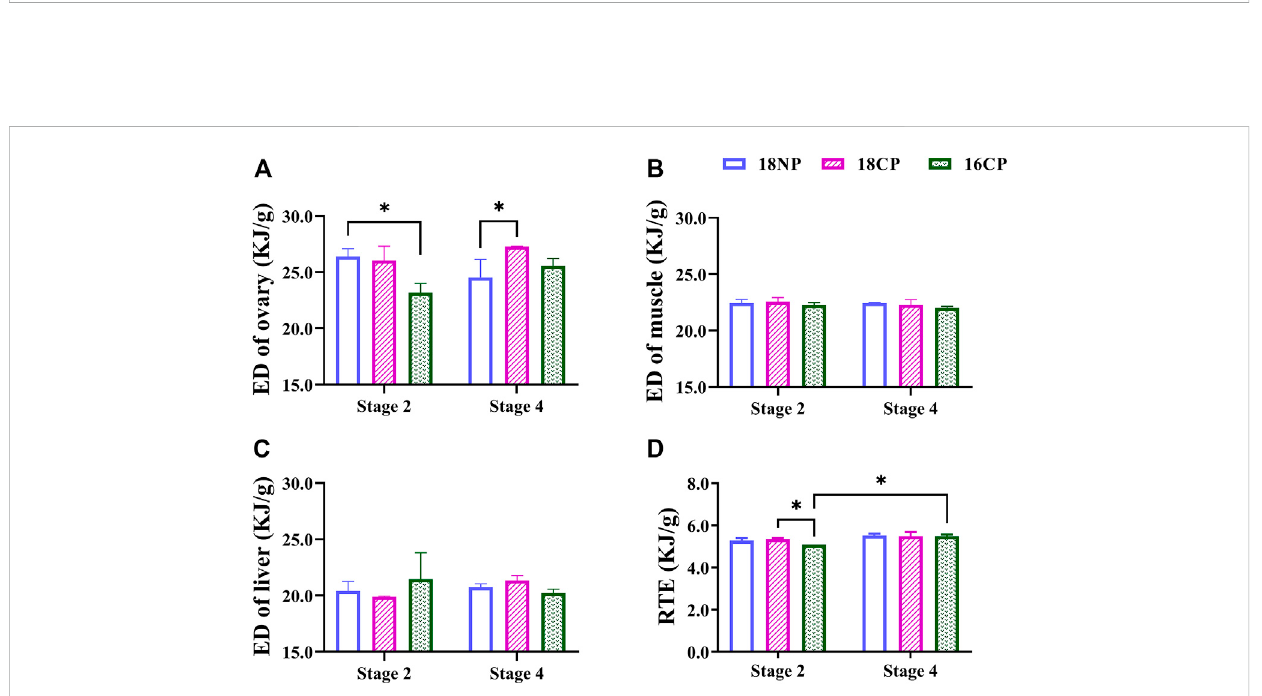
FIGURE 5 Energydensity(ED)oftheovary,muscle,andliverandrelativetotalenergy(RTE)offemalelargemouthbass. (A) EDoftheovary. (B) EDofmuscle. (C) EDoftheliver. (D) RTEofthetotalindividual.RTEwascalculatedbythesumoffourmainpartsofenergystoragerelativetobodyweight,includingmuscle EDmultipliedbydryevisceratedweight,liverEDmultipliedbyitsdryweight,gonadEDmultipliedbyitsdryweight,andmesentericfatEDmultipliedbyits dry weight. Asterisk (*) indicates a signi fi cant difference between Stage 2 and Stage 4, or between treatment groups. Stage 2 , the supposed maturation of the ovary, right after the temperature increase, on 25 September. Stage 4 , the supposed spawning peak, spawning was observed in all treatment groups, on 21 November. 18NP , 18 ° C overwintering water temperature, natural photoperiod group. 18CP , 18 ° C overwintering water temperature, controlled photoperiod group. 16CP , 16 ° C overwintering water temperature, controlled photoperiod